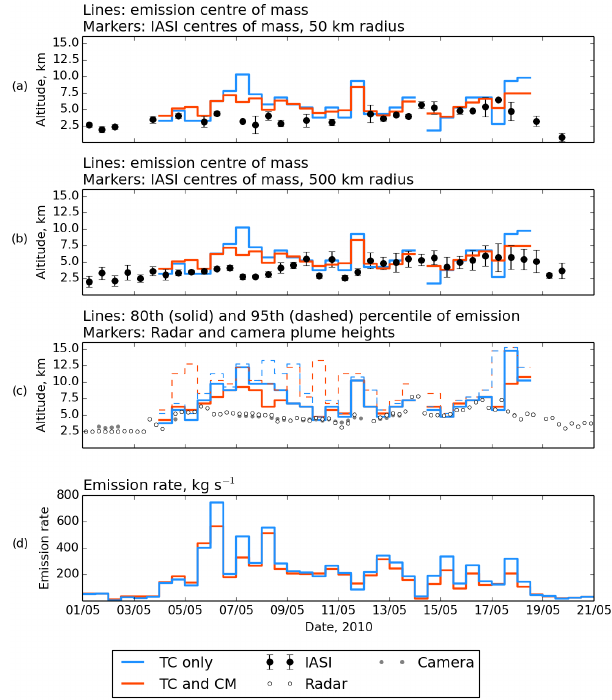
Figure 8. Inversion results for Eyjafjallajökull. Panels (a) and (b) : centre of mass of SO 2 injection and the average IASI plume height within 50 and 500km from the volcano; panel (c) : 95th and 80th percentiles of SO 2 injection and the plume top altitudes observed by radar and camera; panel (d) : estimated emission rate (kgs − 1 ) . Inversions using only total column retrievals are plotted in blue; in- versions using total column and plume height retrievals are plotted in red. Fully correlated errors are assumed for evaluating the error bars for IASI data. The data with retrieval error estimate larger than 5km are not included. The radar and camera observations are av- eraged to time steps of 6h. The centres of mass and percentiles of the inversion results are evaluated for the 12h steps emitting at least 1% of the total emission. All altitudes are above sea